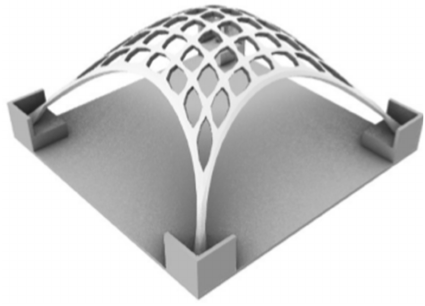
Figure 9: Bricks design process scheme – starting from the equili- brated form diagram output of the TNA, the bi-dimensional geome- try of the bricks has been